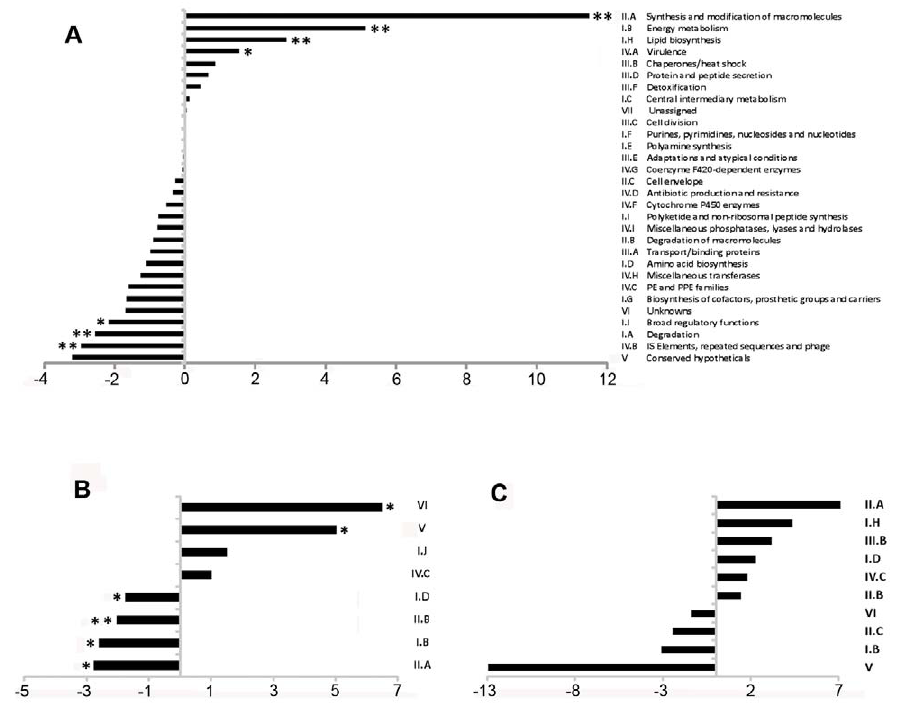
Figure 1. Representation of functional classes in the M.tuberculosis transcriptome. Transcripts identified by sequence analysis were grouped according to the functional class of their predicted gene product as assigned in the original genome annotation [10]. For all panels, values on the x-axis represents a difference in percentage, positive values indicate over-representation of a particular functional class whereas negative values indicate under-representation. Panel A shows the difference in the percentage of the functional classes among the 10% highest expressed genes of the transcriptome (N=400) when compare to the percentage observed in the annotated genome. Panel B shows the difference in percentage of selected functional classes when comparing the transcripts with abundant antisense levels (antisense to sense ratio . 0.5, N=435) with the total set of CDSs with RPKM $ 5 (N=3,136). Panel C shows the difference in percentage for selected functional classes when comparing the transcripts with abundant 5’ UTRs (see text for details, N=82) with the total set of CDSs with RPKM $ 5 (N=3,136). For B and C, no significant differences in representation were observed for functional classes that are not shown. * p , 0.05 using Fisher’s exact test. ** significant after multiple test correction (False Discovery Rate